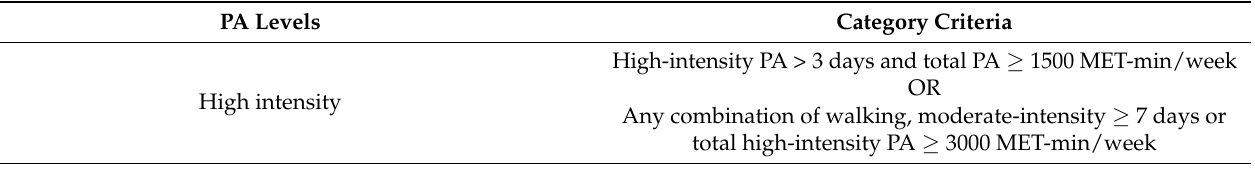
Table 3. International Physical Activity Questionnaire (short form) category